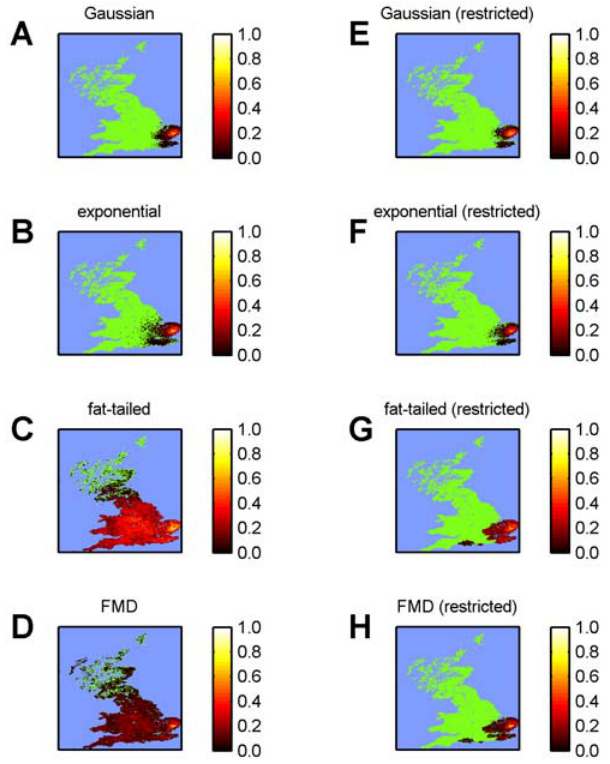
Figure 4. Spatial dynamics of BTV-8 in GB during 2007. Predicted spatial distribution of affected farms as of 31 December 2007 assuming: (A,B) a Gaussian kernel; (C,D) an exponential kernel; (E,F) a fat-tailed kernel; or (G,H) the FMD kernel. Transmission between farms is either (A,C,E,G) unrestricted or (B,D,F,H) restricted to the 2007 PZ. Each map shows the cumulative risk (see colour bars) expressed as the proportion of simulated outbreaks (out of 50 which took off; see Methods) for which at least one farm was affected by BTV within each 5 km grid square.